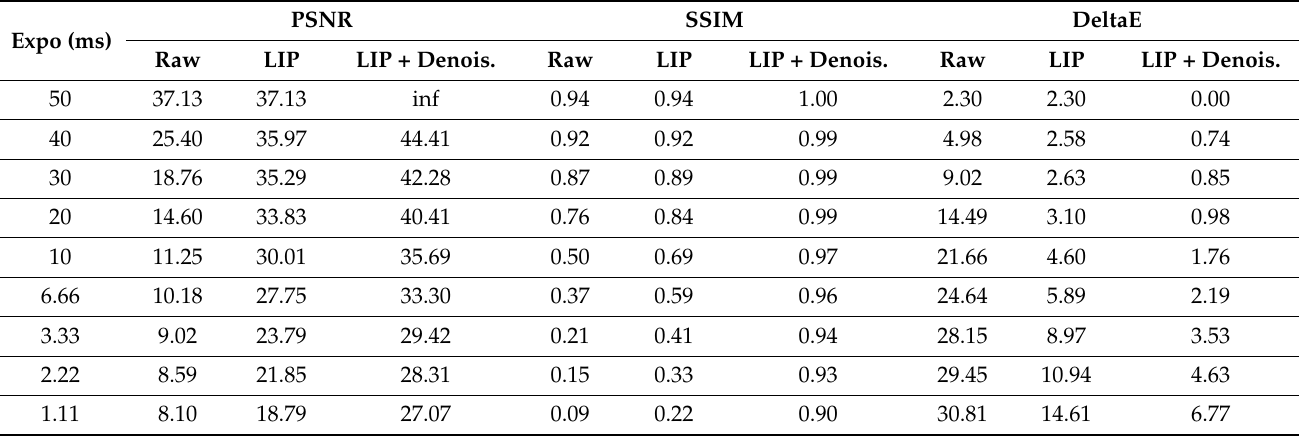
Table 1. PSNR, SSIM, and Delta E values according to images exposures and processing step (raw, LIP enhancement, and LIP + CNN denoising).